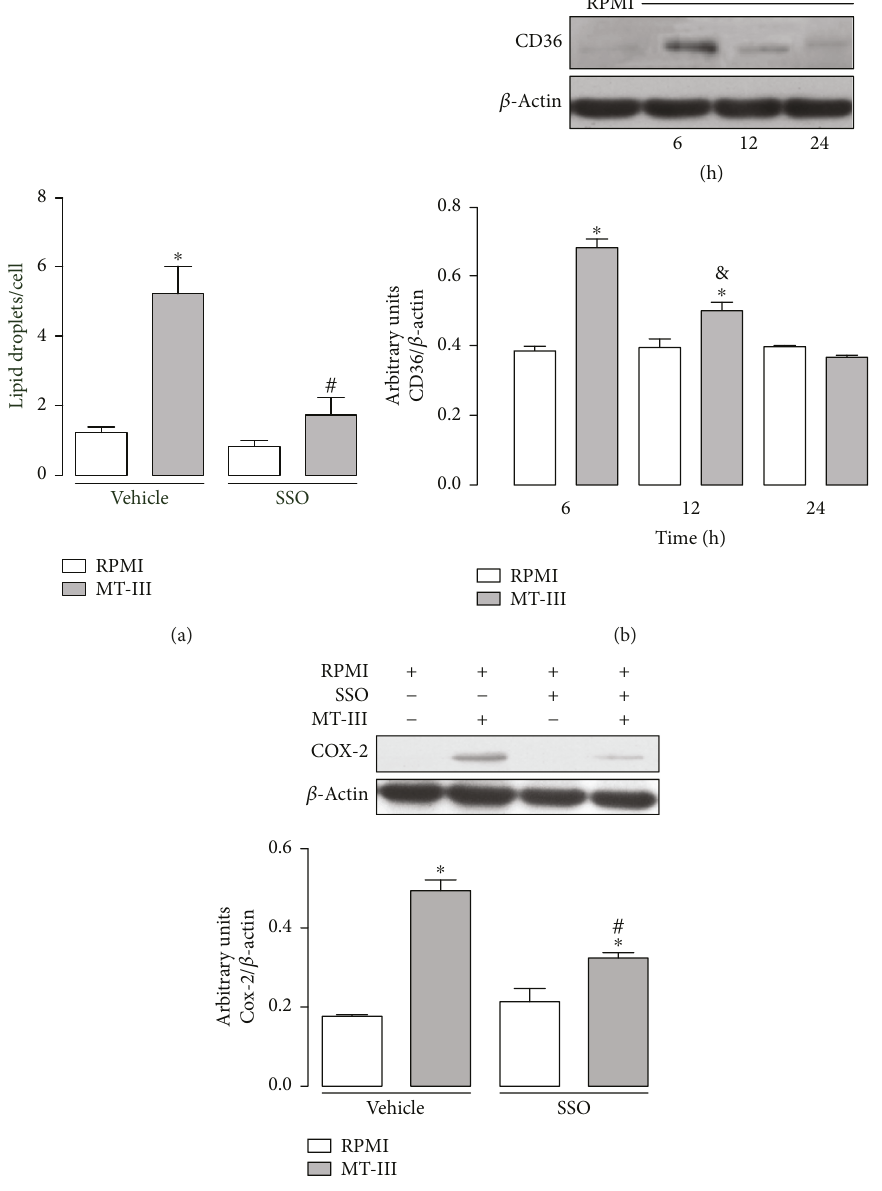
Figure 6: MT-III-induced LD formation and COX-2 protein expression in macrophages are dependent on CD36. (a) Peritoneal macrophages were incubated with SSO (25 μ M) compound or vehicle ( < 1% DMSO/RPMI) for 30min and then with MT-III (0.4 μ M) for 12h. LDs were quanti fi ed using light microscopy after osmium staining. Each bar represents the mean ± SEM LDs/cell in 50 counted cells. Values represent means ± SEM from 3 – 5 animals. ∗ p < 0 05 compared with the control group; # p < 0 05 compared with vehicle-treated MT-III-stimulated cells. (b) Western blotting and densitometric analysis of CD36 and β -actin (loading control) in macrophage extracts. Peritoneal macrophages were incubated with MT-III (0.4 μ M) or RPMI (control) for 6, 12, and 24h. ∗ p < 0 05 compared with controls; & p < 0 05 compared with MT-III 6h. (c) Western blotting and densitometric analysis of COX-2 and β -actin (loading control) in macrophage extracts pretreated with CD36 antagonist, SSO. # p < 0 05 compared with vehicle-treated MT-III- stimulated cells. Peritoneal macrophages were incubated with SSO (25 μ M) compound or vehicle ( < 1% DMSO/RPMI) for 30min and then with MT-III (0.4 μ M) for 12h. The densities (in arbitrary units) were normalized with those of β -actin. Results are expressed as mean ± SEM from three experiments. ∗ p < 0 05 compared with